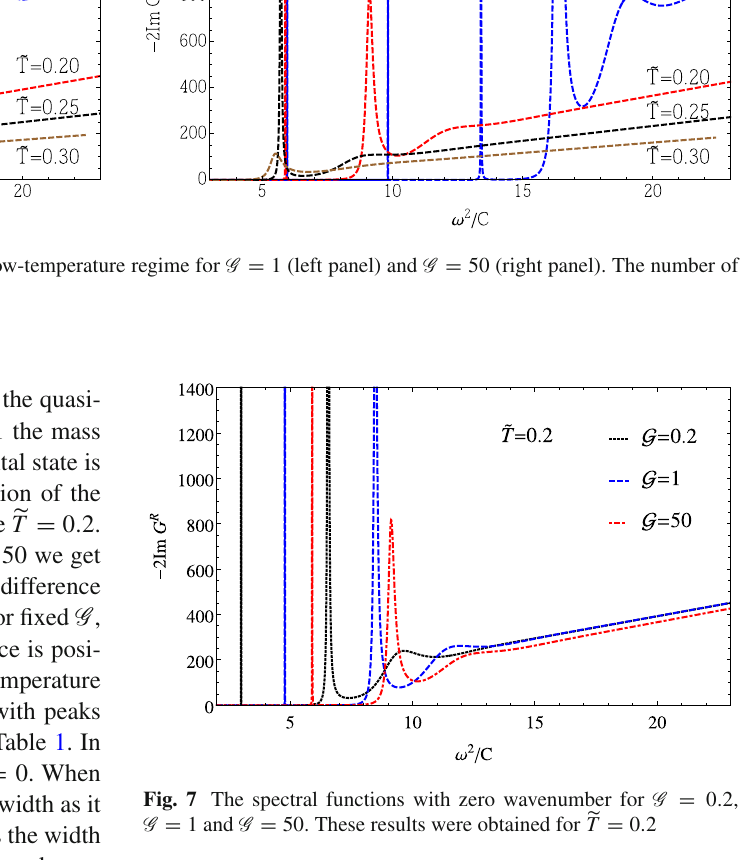
by the SPFs where there are two peaks for the same tem- perature. The effect of the parameter G shows up in shifting the position, height, and width of the peaks (see Fig. 7). In other words, the position, height and width of the peaks are (cid:10) ( (cid:10) T , G ) and Γ ( (cid:10) T , G ) . T and G too, i.e., ω functions of 0 to more ener- It is noticed that the parameter G shifts ω 0 getic states, while the width of the peak increases. To finish the analysis of the SPFs we consider a finite spatial momen- tum in the above results, i.e., q (cid:12)= 0. Hence, the quasiparticle states have spatial displacement and therefore become more energetic. The results for this case are presented in Fig. 8 for G = 1 (left panel) and G = 50 (right panel). The addition of spatial momentum shifts the position of the peaks to more energetic states, and the half-widths also increase as the spa- tial momentum increases. This means that more energetic states, i.e., quasiparticles with higher momenta, have shorter lifetime and therefore they melt faster than the low energy